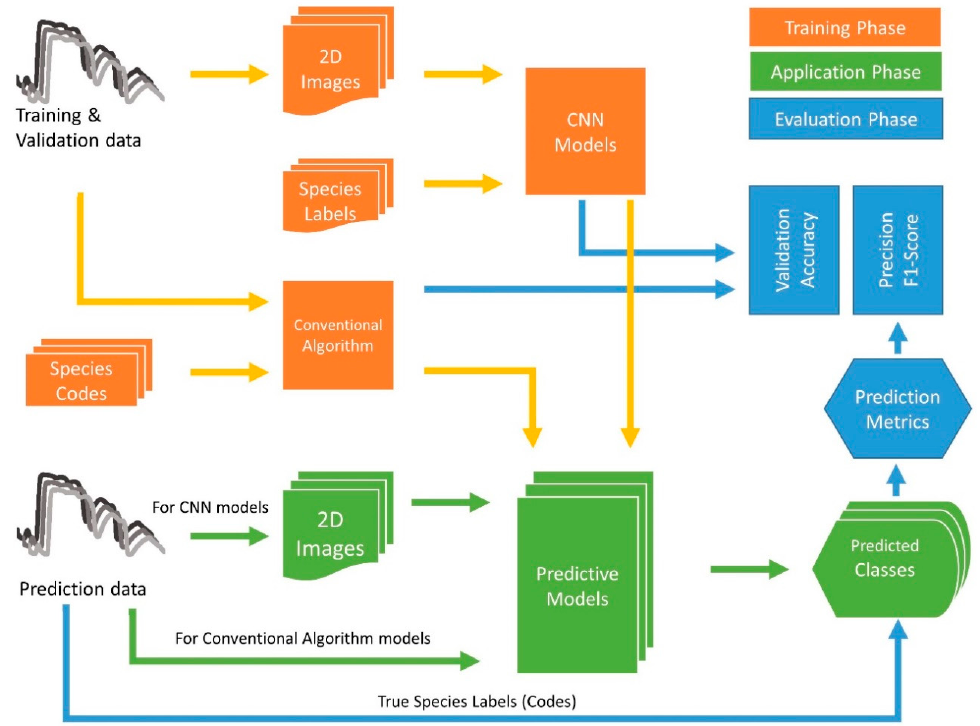
Figure 5. Flowchart of the process followed in this study [4]. In the training phase, 1D structured reflectance data are reshaped into a 2D grey image as the input for CNN models, while 1D data are used for DCN and conventional algorithms. The application phase is a simulated phase using unseen data for trained model prediction. Unseen data are from different areas, labs, or years. Predicted and actual species are compared to generate prediction metrics.